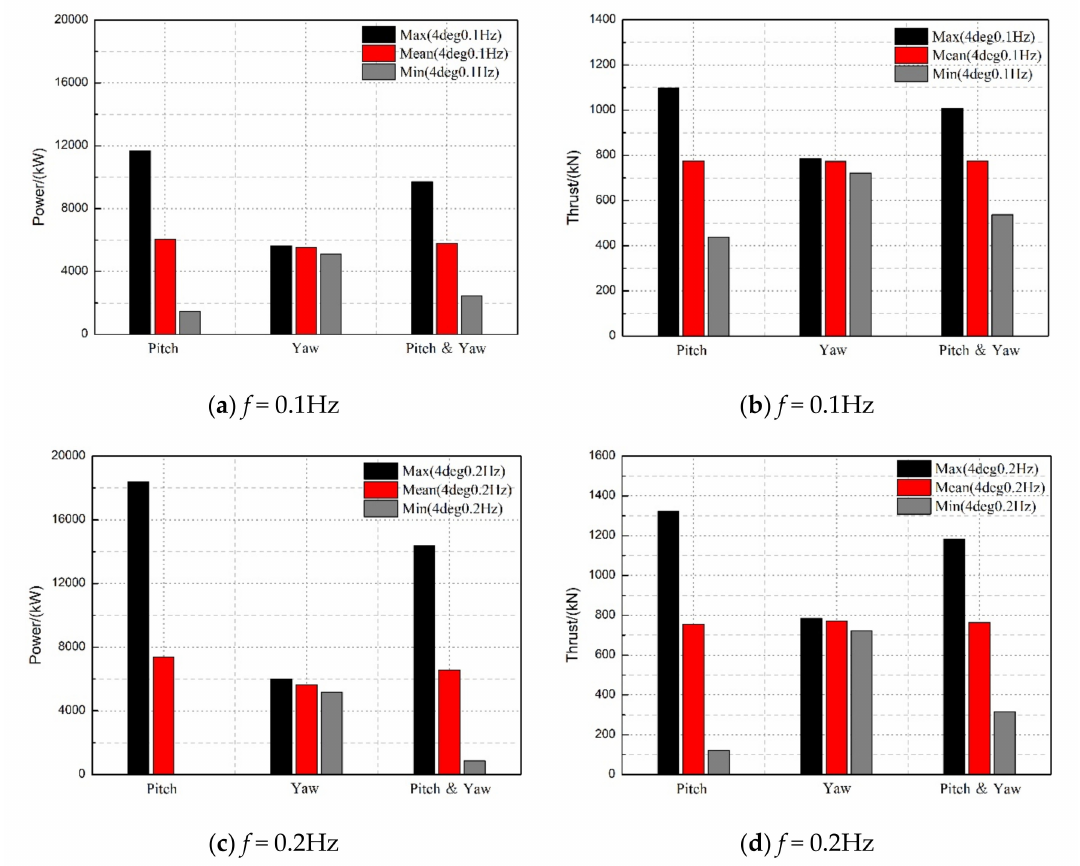
Figure 9. Extreme and average values of the total